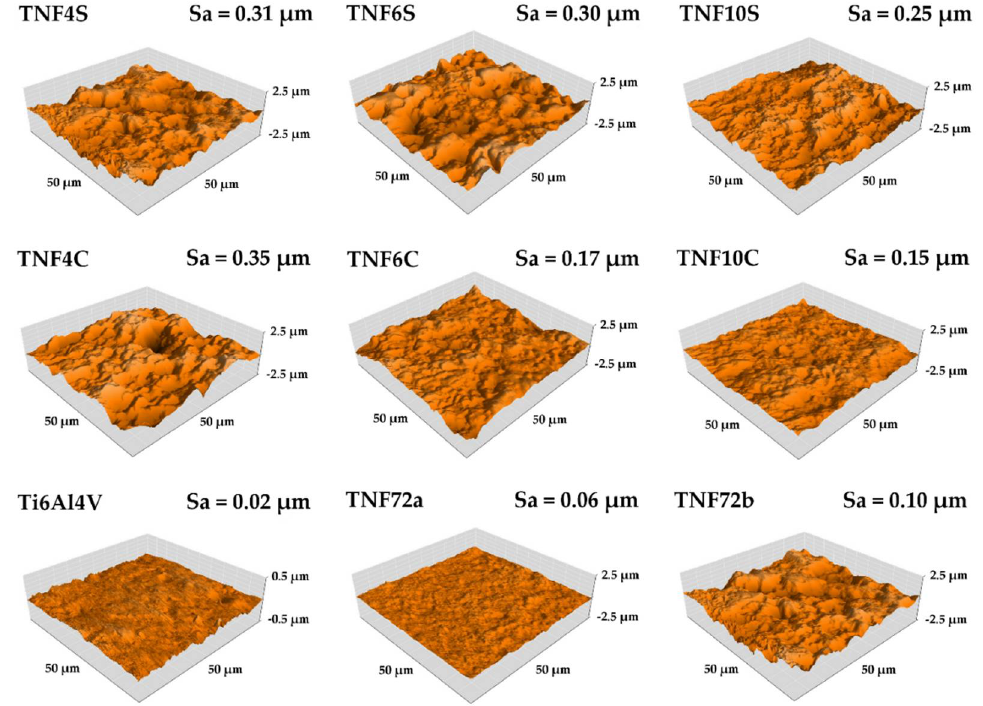
Figure 4. The Atomic Force Microscopy (AFM) topography of Ti6Al4V and TNF samples with Sa parameter values.